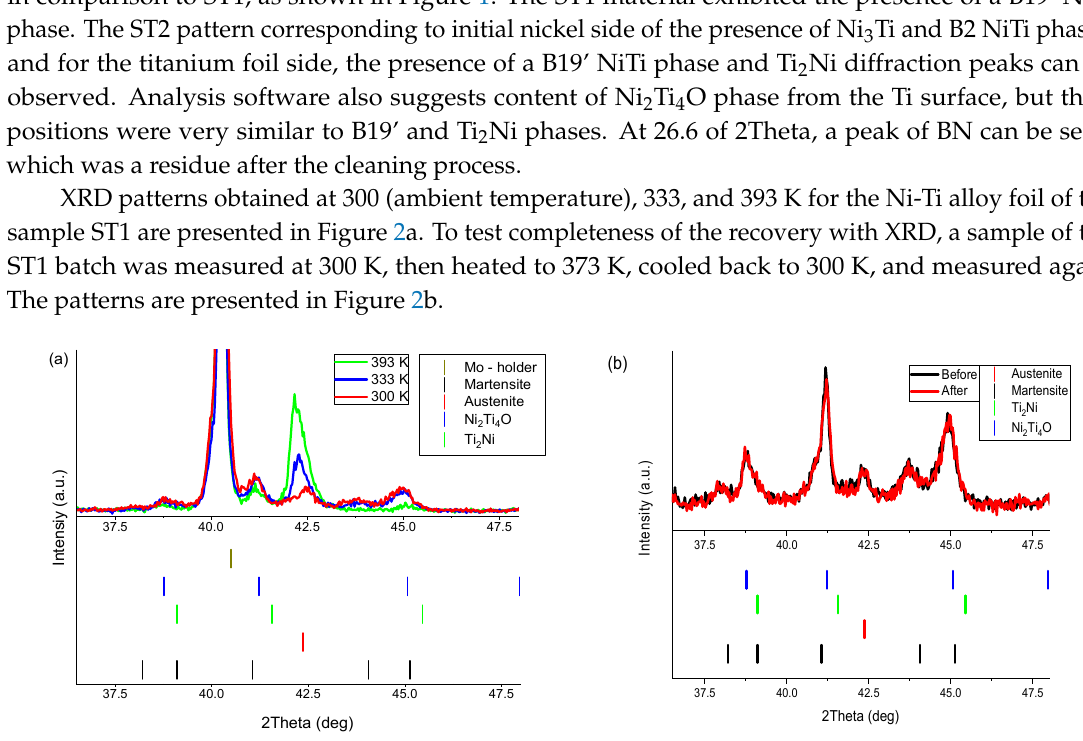
Figure 2. X-ray diffraction patterns ( a ) at various temperatures for the sample ST1: red, blue, and green corresponds to 300, 333, and 393 K. ( b ) Patterns at 300 K: before and after heating to 373 K. Structural peaks of the phases present are marked, respectively.